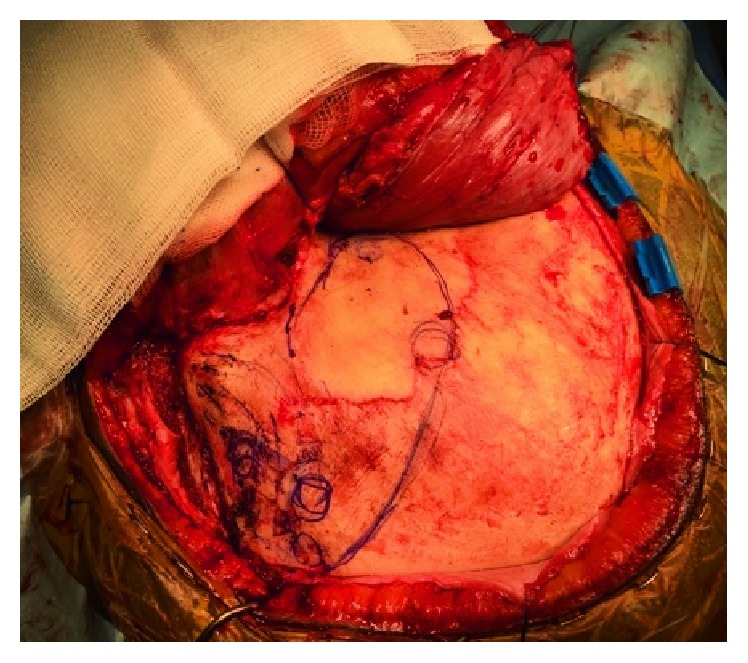
Mastoid drilling.